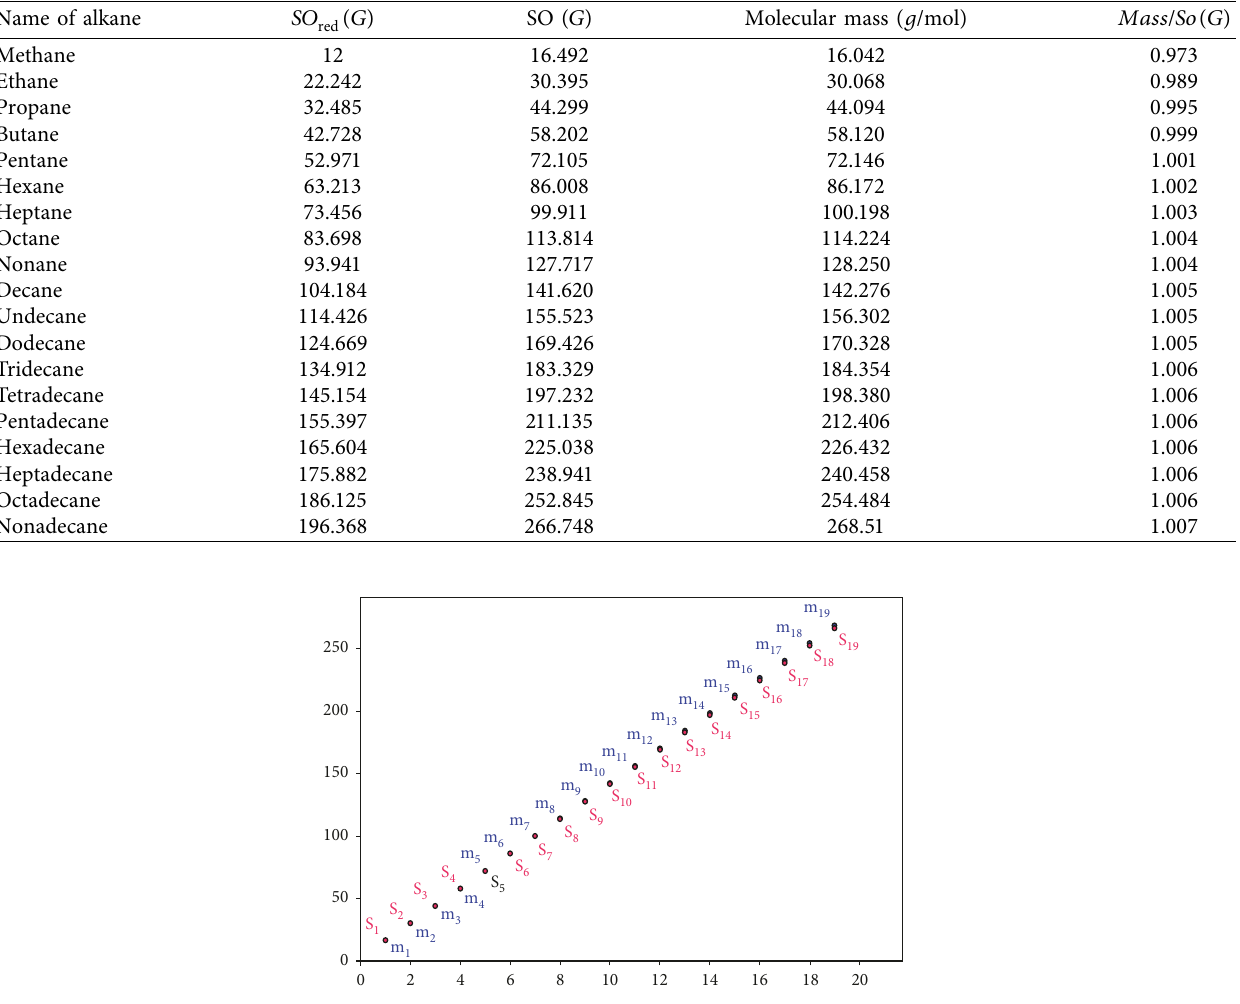
Table 1: Sombor index and molecular mass of some alkanes.